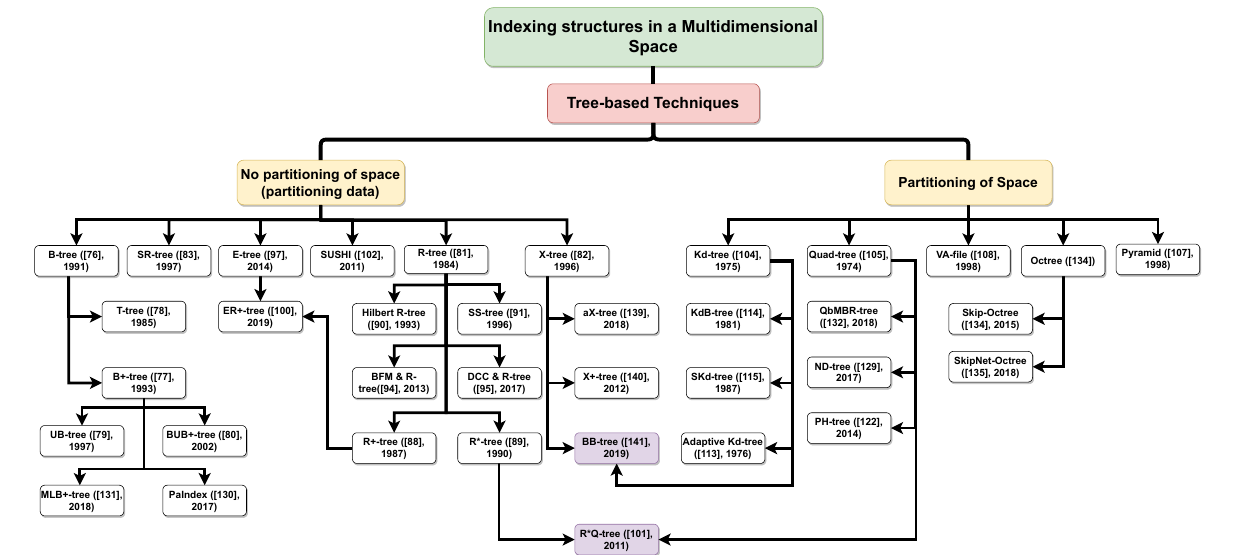
Figure 8. Taxonomy of tree-based indexing